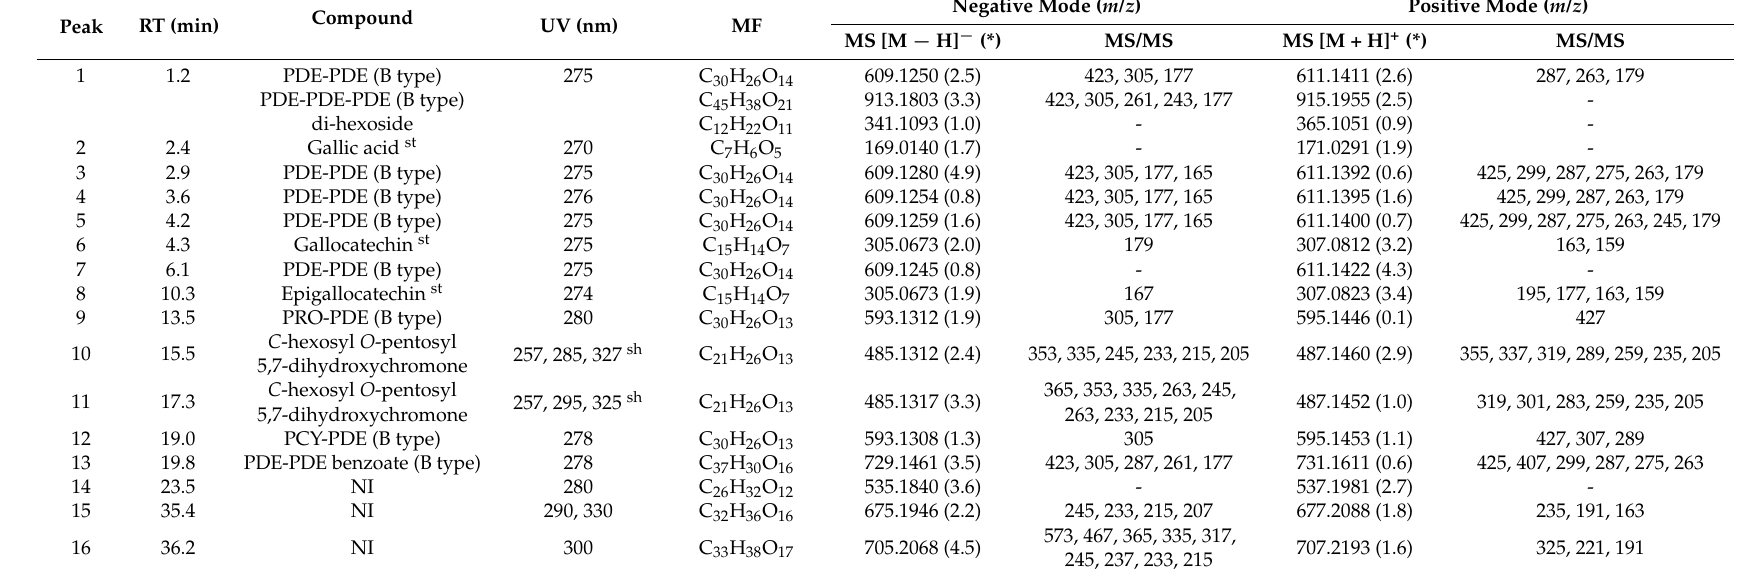
Table 1. Identification of the constituents from S. adstringens aqueous extract (SAAE) by LC-DAD-MS/MS.